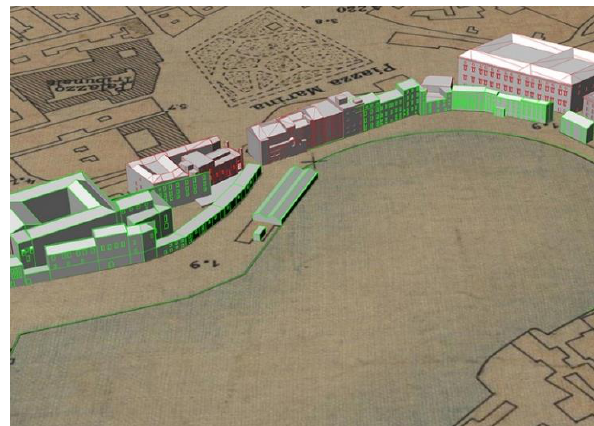
Figure 8: The 3D reconstruction model of the ‘Cala’.